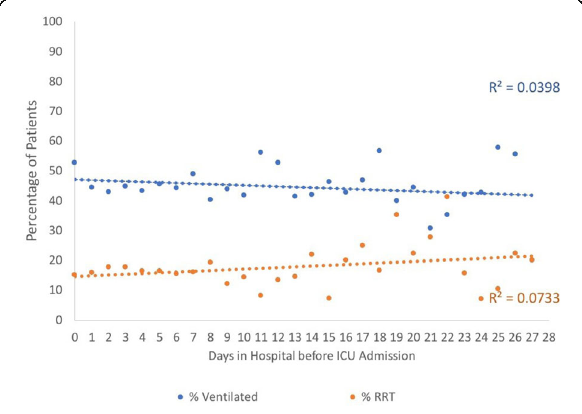
Fig. 4 (abstract 000128). Percentage of patients requiring invasiveventilation and RRT with respect to lenght of hospital stay prior toICU